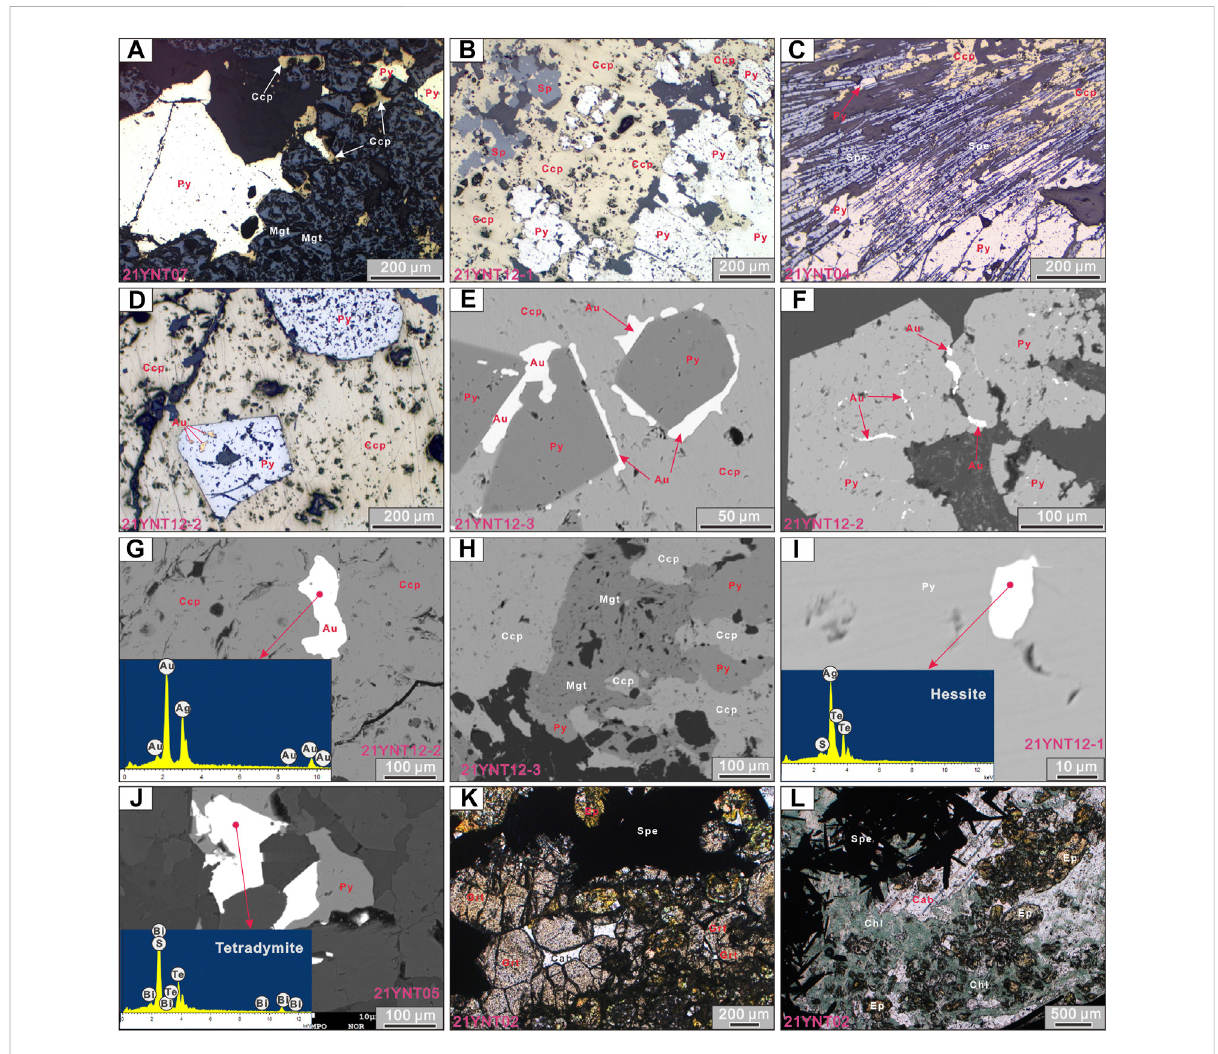
FIGURE 6 Photomicrographs of Au – Cu mineralization in Tongjing deposit. (A) Pyrite and chalcopyrite fi lled along the gap of subhedral magnetite; (B) Pyriteisreplaced bychalcopyrite alongtheedgesofpyrite,chalcopyrite overprintedbysphalerite; (C) Acicular specularite fi lledorreplaced bypyrite and chalcopyrite; (D) Natural gold occurring in euhedral pyrite as irregular particles, they wrapped by chalcopyrite; (E) Irregular or granular natural gold grew along the outer edge of euhedral pyrite, they appearing in chalcopyrite in BSE images; (F) Irregular stripped native gold occurring in fi ssures inside the euhedral pyrite in BSE images; (G) Silver-bearing natural gold wrapped in chalcopyrite in BSE images; (H) Chalcopyrite, pyrite and early residual magnetite occurring in Au – Cu ores; (I) Pyrite containing spindle-shaped hessite; (J) Pyrite and tetradymite growing together; (K) Carbonate veins fi lled along the gap of euhedral garnet, epidote replacing garnet around the edge of garnet; (L) Epidote, chlorite and carbonate alterations with specularite. Sp – sphalerite; Au – native gold; other abbreviations as for Figure